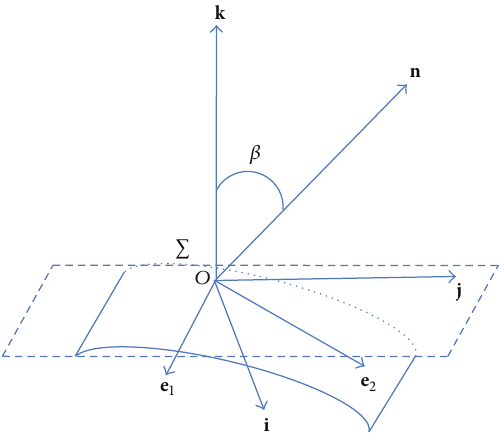
Figure 2: Scheme of wavefront arriving at a Common Shot Point.